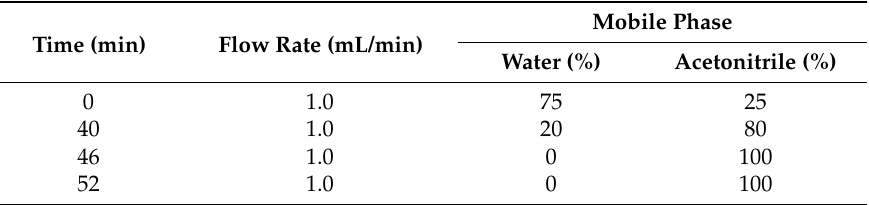
Table 1. Condition of mobile phase for HPLC analysis .